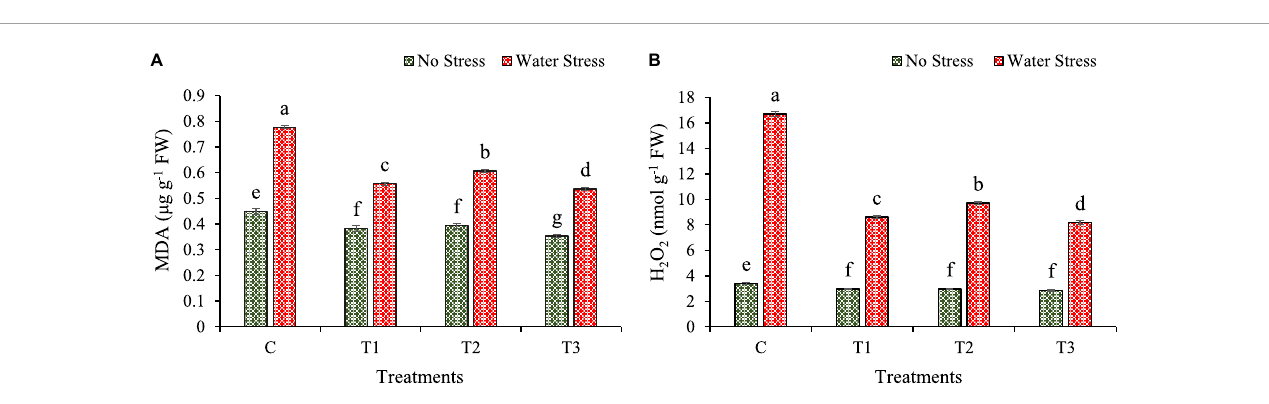
FIGURE7 Impacts of bacterial treatments (T1 — Enterobacter cloacae BHUAS1, T2 — Bacillus megaterium BHUIESDAS3, and T3 — Bacillus cereus BHUAS2) on various features of wheat plants under the influence of water-induced drought stress (A) malondialdehyde (MDA) and (B) hydrogen peroxide (H 2 O 2 ). The different alphabets indicate statistically significant differences between each treatment (DMRT p < 0.05).